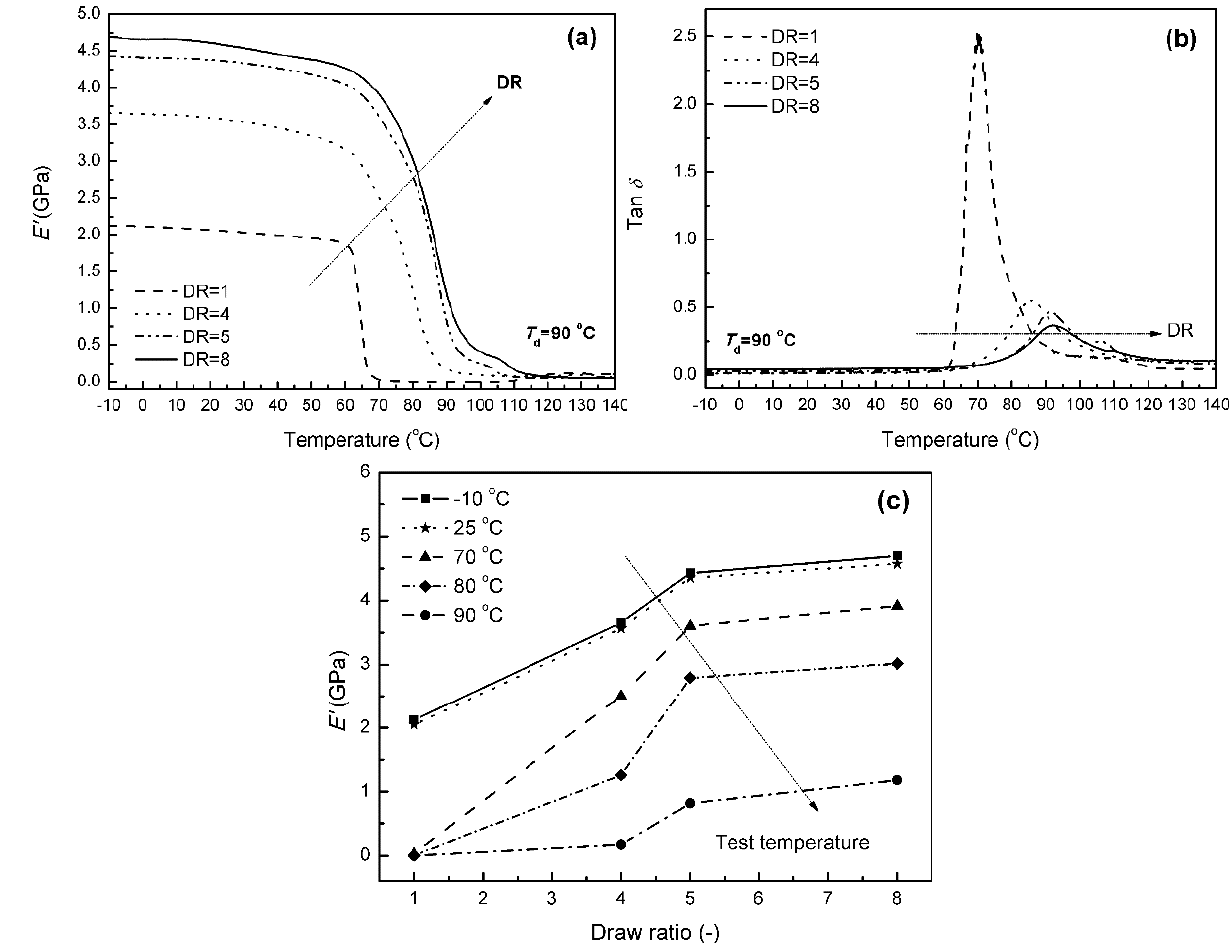
Figure 5. ( a ) Storage modulus and ( b ) loss factor against temperature for a range of PLLA tapes with increasing draw ratio; ( c ) storage modulus vs. draw ratio for a range of PLLA tapes with increasing test